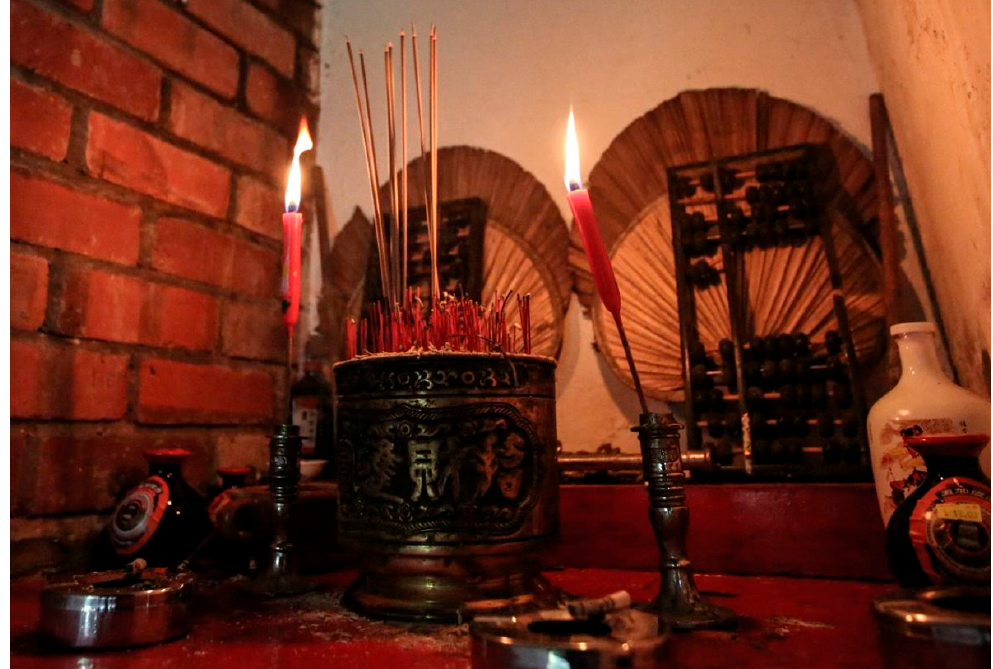
Figure 1. Altar to the Underworld gods in New Heng San Teng temple (Source: PF Foto).